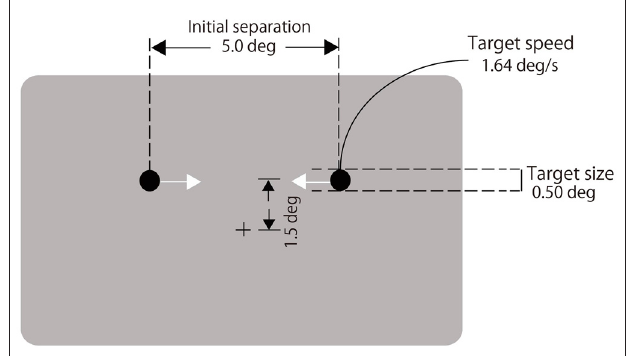
FIGURE 1 | Schematic illustration of the stream/bounce display used in Experiment